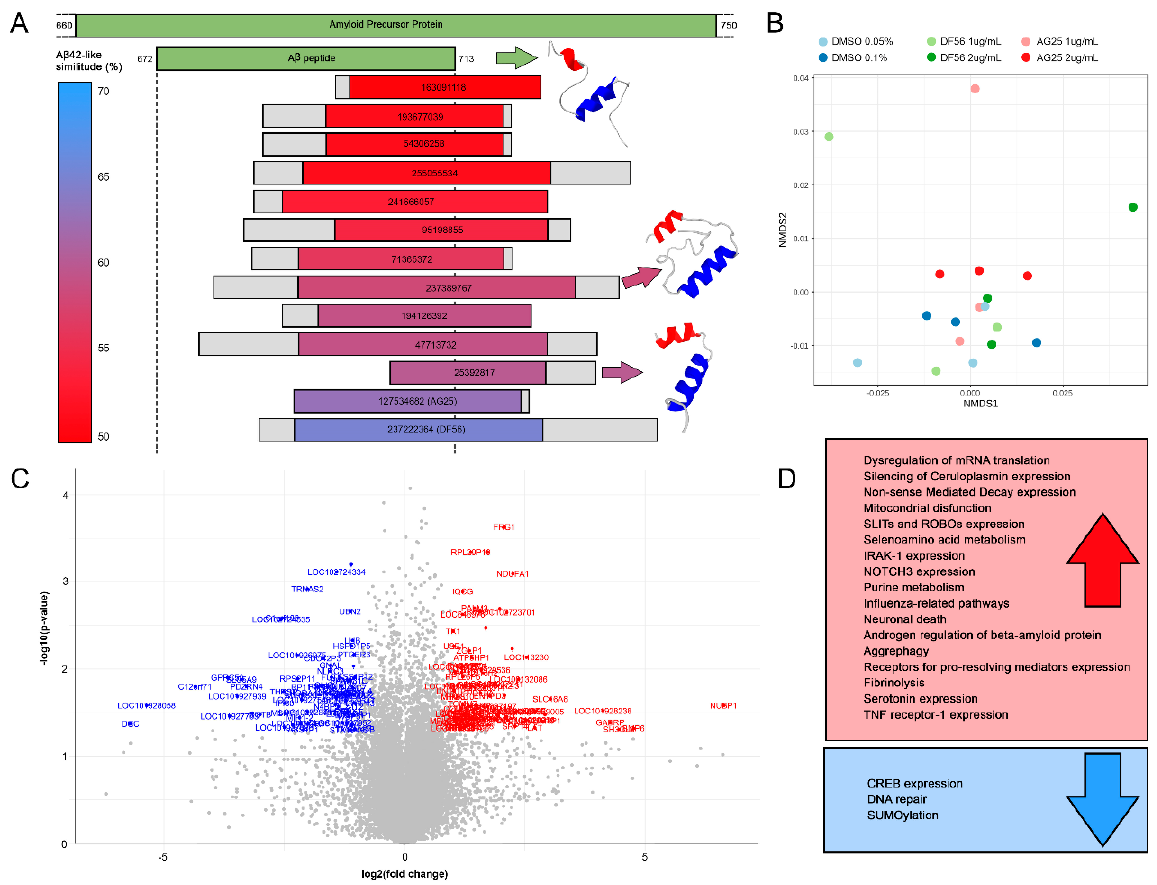
Figure 1. ( A ) From top to bottom, graphical representation of an alignment between human APP, A β 42 and the 13 bacterial peptides contained in the MAHMI database that obtained the best A β 42-like similitude score. The A β 42-like similitude score considers sequence, secondary and tertiary alignment scores and is represented using a similitude gradient scale from red (50) to light blue (70). The coloured fraction of each peptide represents the sequence covered in the sequence alignment. Tertiary structure predictions for the peptides presenting two alpha helices are presented on the right, and are compared with the corresponding and resolved structure of the A β 42 peptide obtained at the Protein Data Bank (https://www.rcsb.org/). ( B ) Nonmetric multidimensional scaling analysis based on the gene expression profiles of the different tested conditions. Bray–Curtis dissimilarity distances over log transformed FPKM (fragments per kilobase of exon model per million reads mapped) were used. ( C ) Volcano plot including genes influenced by DF56 peptide. Log2 of the fold changes (DF56 2 ug/mL compared to DMSO 0.1% v/v ) is represented against the –log10 of the test p -values. Genes showing higher changes [|Log2(FC)| > 1 and –Log10( p -value) > 1.3] are highlighted in red (upregulated) or blue (downregulated). ( D ) Up- (blue) and down- (red) regulated pathways in neuronal differentiated SH-SY5Y cells by DF56 peptide (2 ug/mL) compared to DMSO (0.1% v/v ) control conditions. Only statistically differentially expressed pathways are reported ( p -value < 0.05, FDR < 0.2).